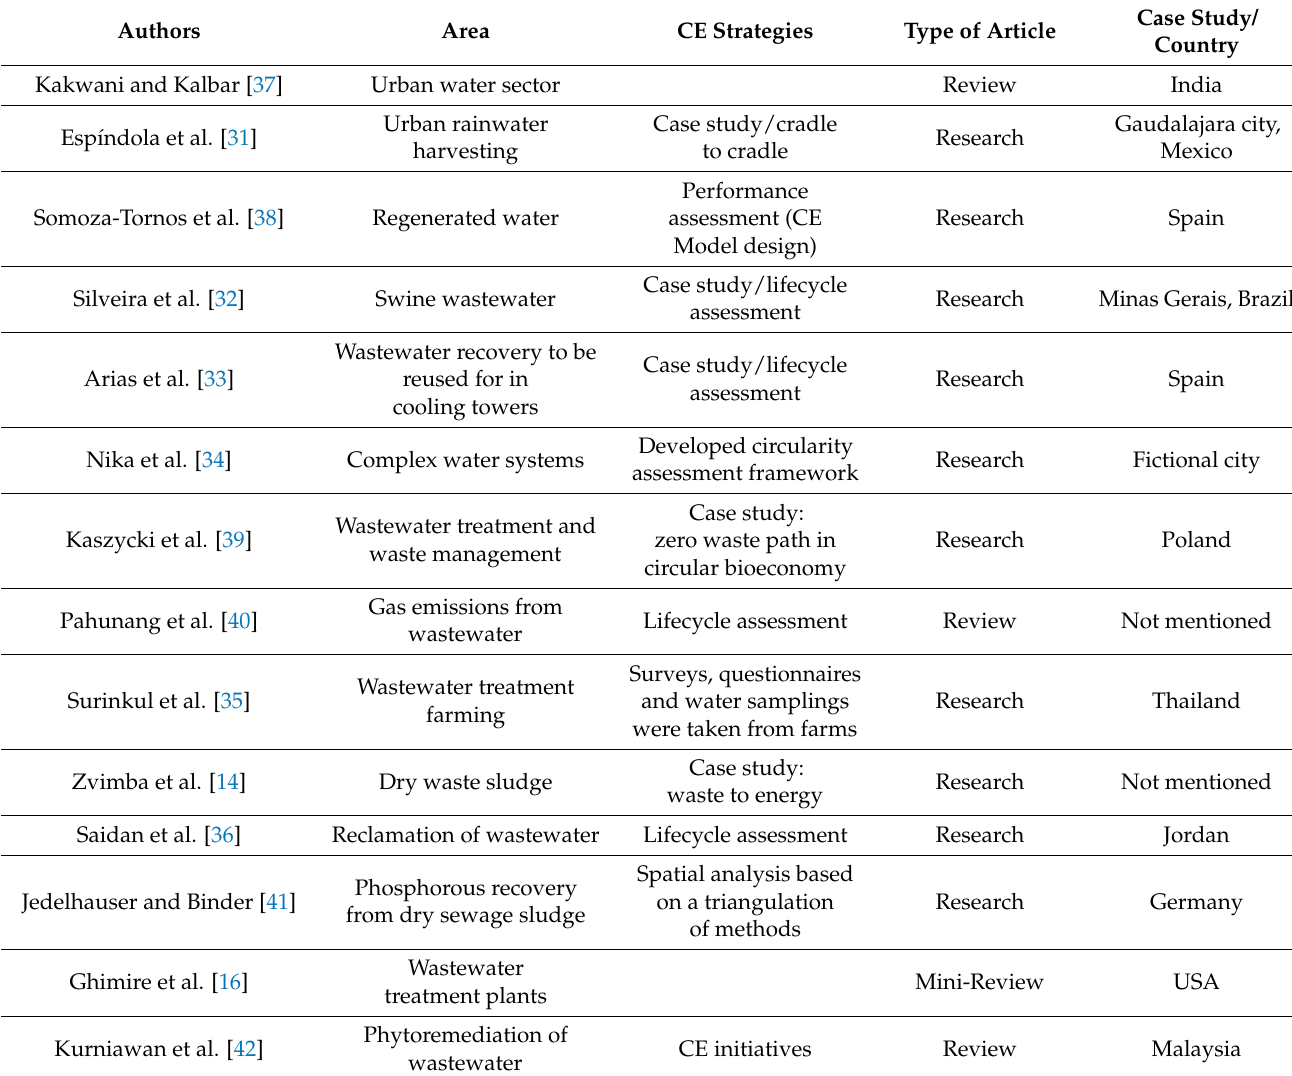
Table 2. Previous studies covering CE in wastewater